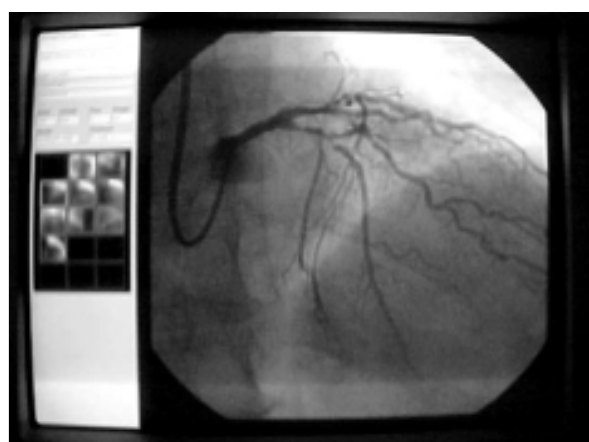
Fig. 4 - Curva de sobrevida acumulada aos oito meses dos 32 primeiros pacientes acima de 75 anos operados sem CEC e sem MAA.